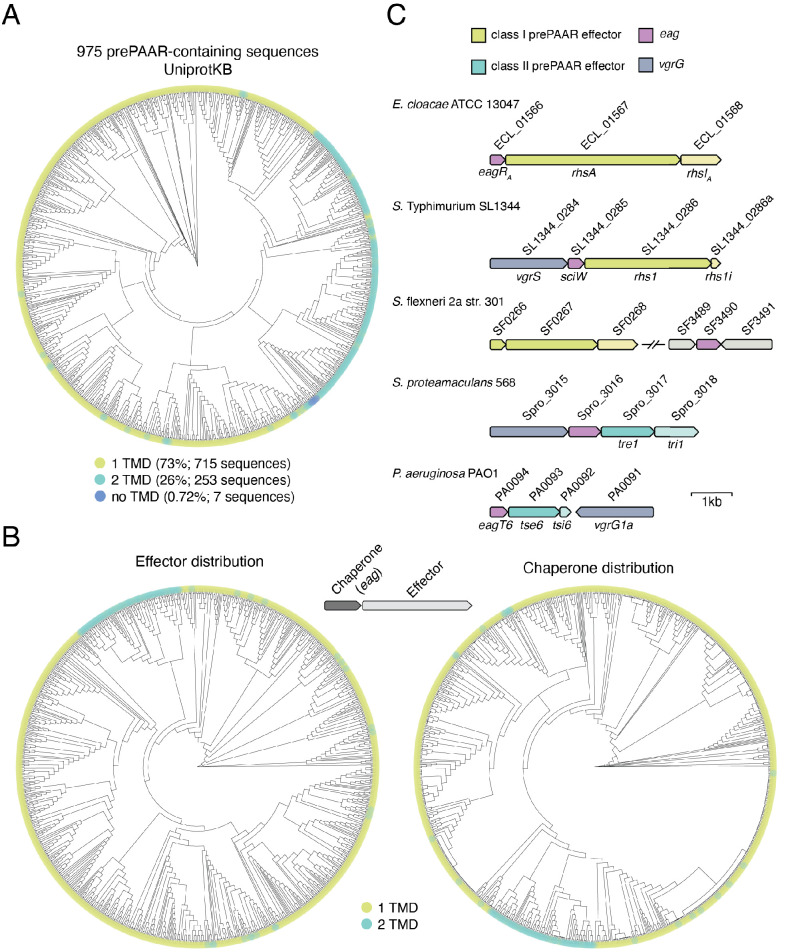
prePAAR effectors contain a fixed number of transmembrane domains.(A) Phylogenetic distribution of 975 prePAAR-containing proteins identified in the UniProtKB database using the N-terminus of Tse6 (Tse6NT) as a search query (see Materials and Methods). The TM helix predictors TMHMM and Phobius (Krogh et al., 2001; Käll et al., 2007) were used to quantify the number of TMDs in each protein (green, 1 TMD; blue, 2 TMDs). (B) Similar analysis as Figure 1E, except that only prePAAR-containing effectors with an adjacent eag gene are depicted (left). The adjacently encoded eag chaperone sequences for each prePAAR effector were then used to build a second tree to depicting their distribution and association with an effector class (right). The eag chaperones were labelled with their neighboring effector’s TMD prediction. All branch length represents evolutionary distance. (C) Genomic arrangement of the five chaperone-effector pairs used for the co-purification experiment shown in Figure 1G. Shading was used to differentiate effector (dark) from potential immunity (light) genes. Locus tags and previously established names for each open reading frame are indicated above and below the gene diagram, respectively. Scale bar indicates 1 kilobase pair.